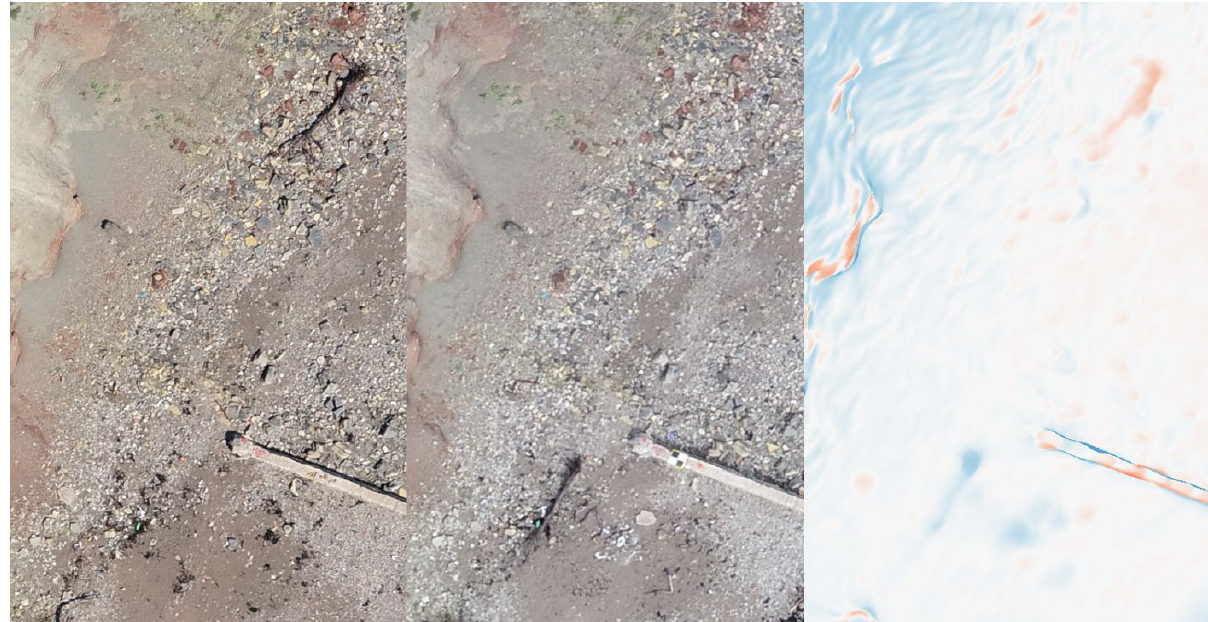
Figure 17 - Zoomed section of the beach near to the cliff face highlighting the movement of the tree trunk and the corresponding erosion/accretion map. (Left: Survey 1; Middle: Survey 2: Right: Difference Map).